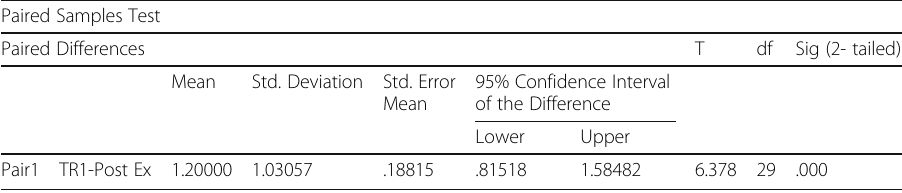
Table 16 Paired-Samples t -test (between the posttest and TR1 of the experimental group) Paired Samples Test Paired